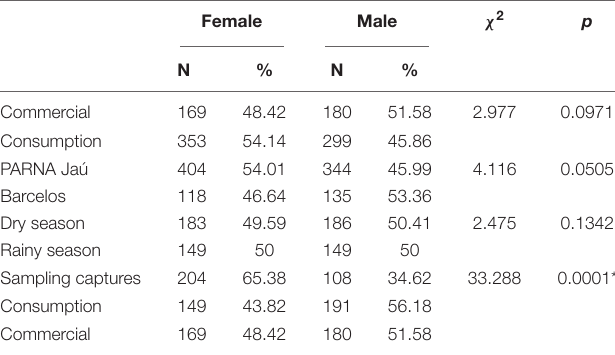
TABLE 3 | Sex ratio of Big-headed individuals ( Peltocephalus dumerilianus ) examined in the Negro River basin, Amazonas, between 1997 and 2019. Female Male χ